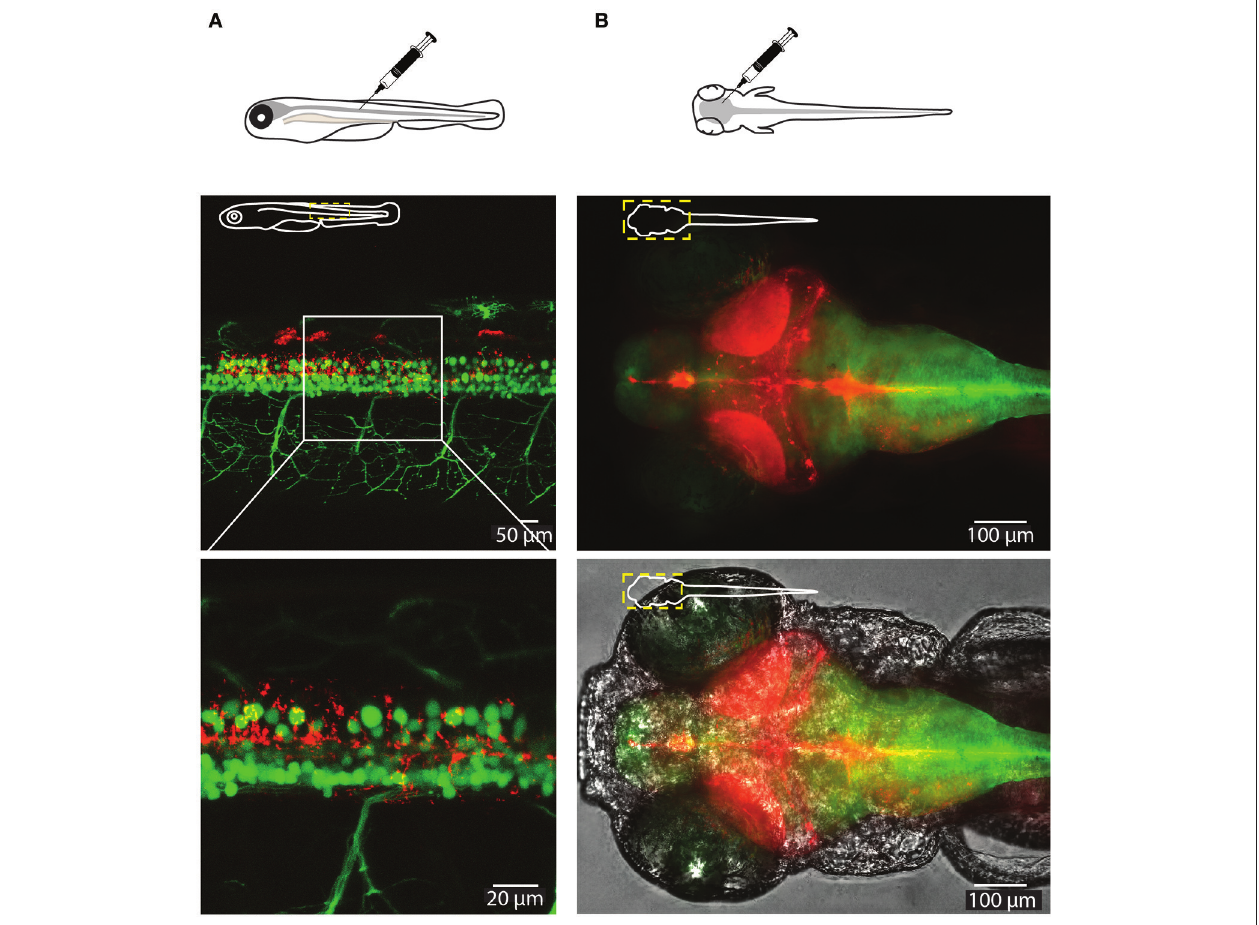
FIGURE 4 | Visualization of CaP-lipid NPs and neurons in the spinal cord and brain of a 6-dpf zebrafish. Sterile filtered non ASO-loaded CaP-lipid NPs containing LissRdB-DSPE (red) were micro injected into the zebrafish spinal cord (A) and brain (B) . (A) Visualization of CaP- lipid NPs containing LissRdB-DSPE (red; injections) within the spinal cord neurons (green; transgenic expression) of a 6-day-old transgenic zebrafish. Zoomed image of the treated zebrafish from area indicated by white box, showing distribution of the CaP-lipid NPs within GFP-expressing spinal cord neurons. (B) Expression of brain-injected CaP-lipid NPs (red) in a transgenic zebrafish expressing astrocyte-specific GFP [green; Tg(GFAP:GFP)] to highlight the brain-specific delivery of these particles. The bottom image overlays the bright-field channel for better visualization of the CNS. The schematic inserts in panels depict the orientation of the fish and outline the presented